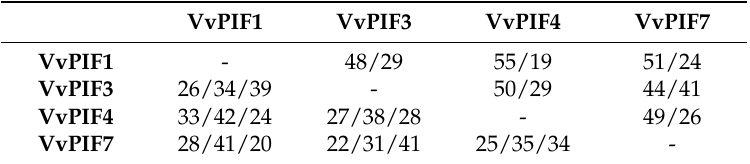
Table 2. Coding region nucleotide (upper portion of matrix) and amino acid (bottom portion of matrix) sequence pairwise comparisons (% similarity) between grape PIF